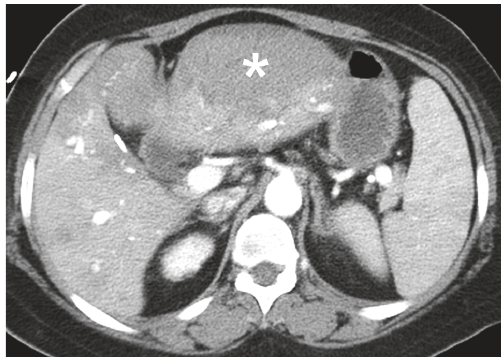
Figure 1: The computed tomographic angiography of abdomen of first time revealed subcapsular hematoma (asterisk) with contrast extravasation at left lateral segment of liver.